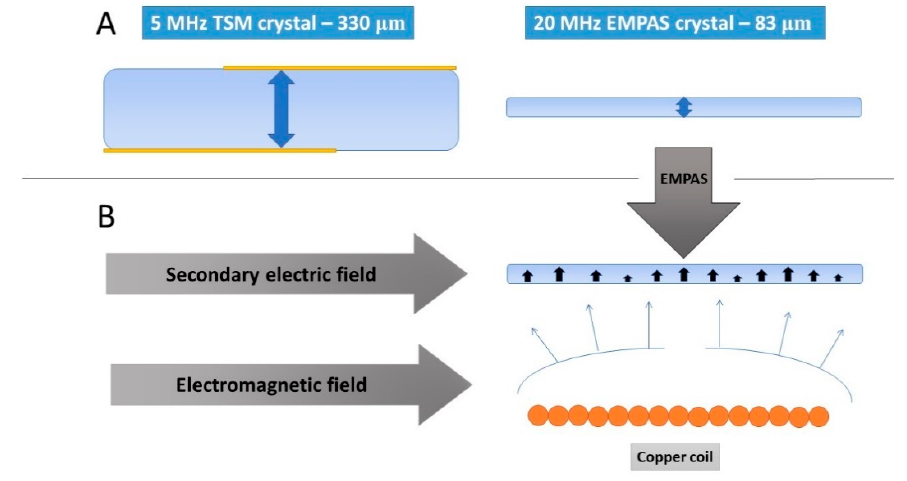
Figure 5. ( A ) The design and the typical thickness of the quartz crystals for the TSM and electromagnetic piezoelectric sensor (EMPAS) applications. ( B ) Schematic representation of the generation of the oscillation by the secondary electric field in the EMPAS.